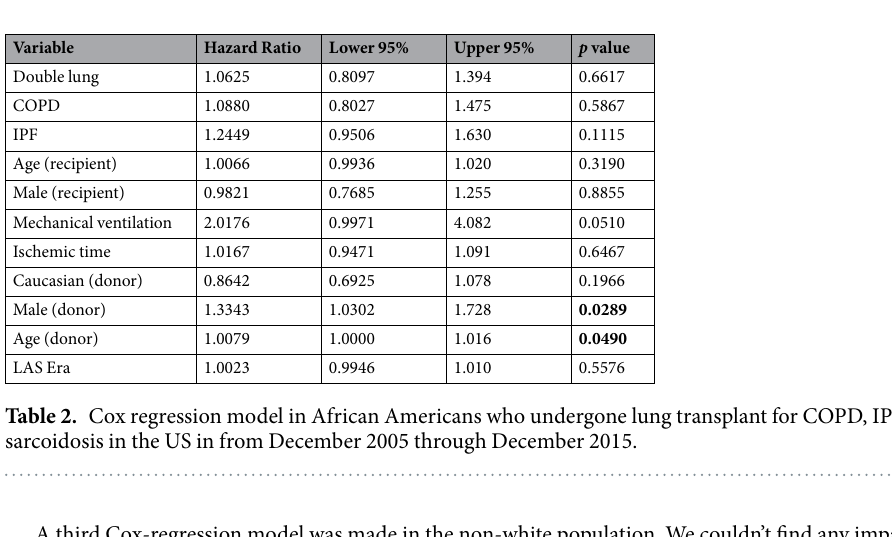
Figure 3. Kaplan Meier curves displaying post-transplant survival rates among not double lung and double lung transplant.